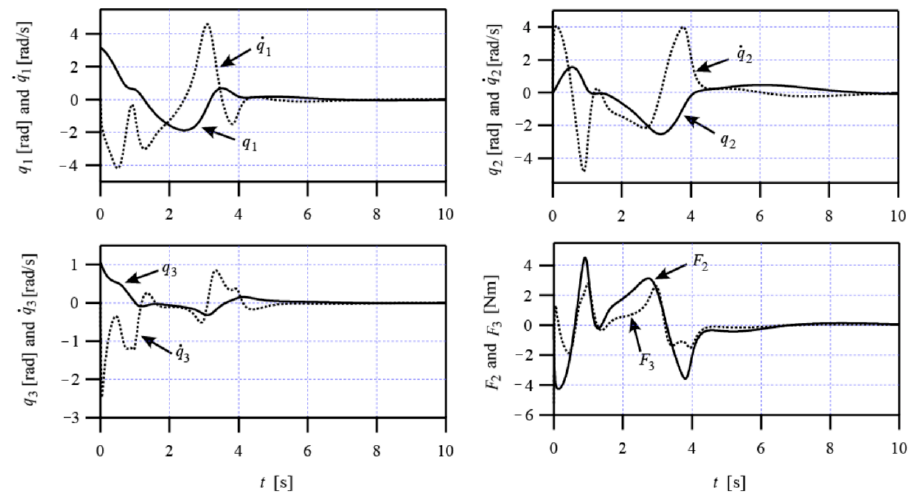
Figure 2. Simulation results for the control system (1) and (2).